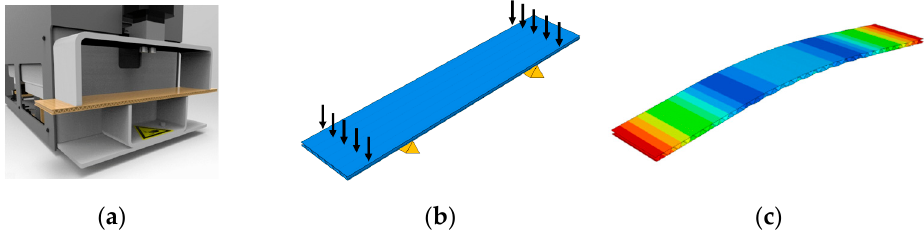
Figure 1. The four ‐ point bending test: ( a ) cardboard testing device; ( b ) loaded sample; ( c ) de ‐ formed sample.